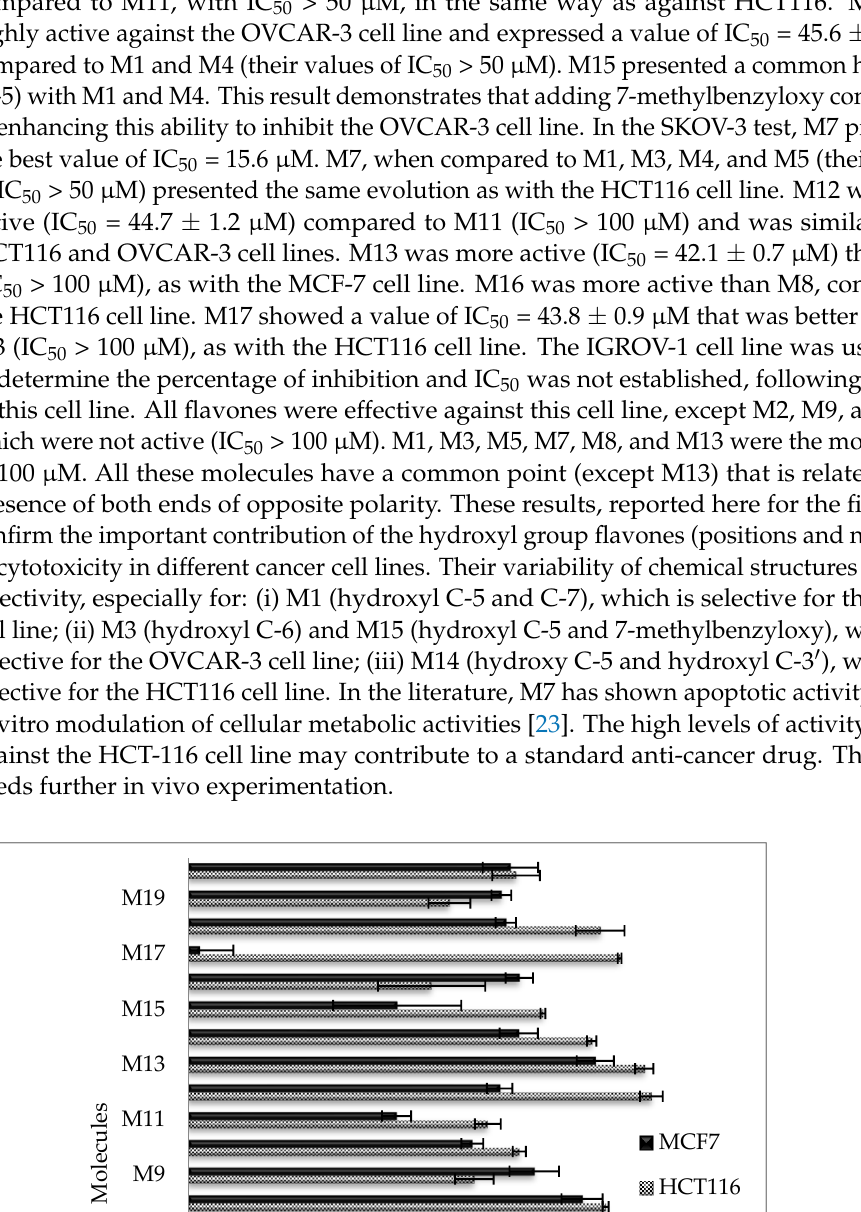
Figure 2. Cytotoxic activity of flavones (100 µM) against the SKOV, OVCAR-3, and IGROV-1 cancer cell lines. Table 4. Anti-cancer activity: the IC 50 (µM) values of flavones tested against HCT 116, MCF 7 SKOV, and OVCAR-3 cancer cell lines (IGROV-1 was not available to establish the IC 50 ). Cancer Cell Line Molecule